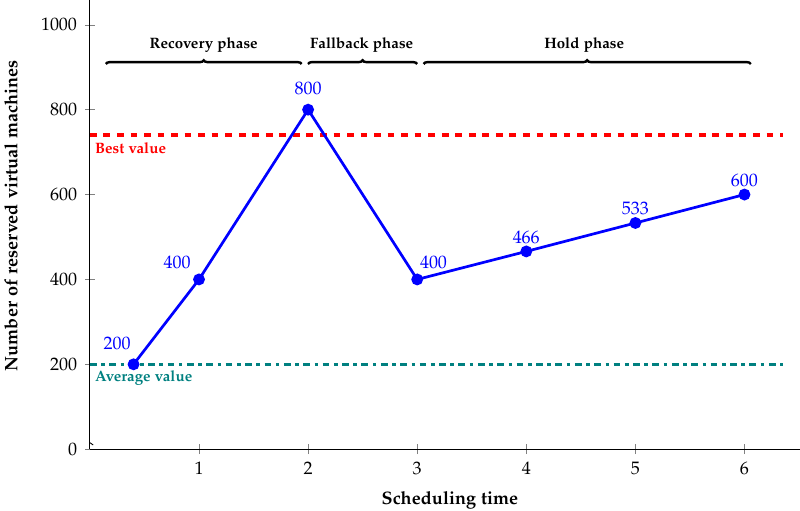
Figure 7. Schematic diagram of virtual machine reservation